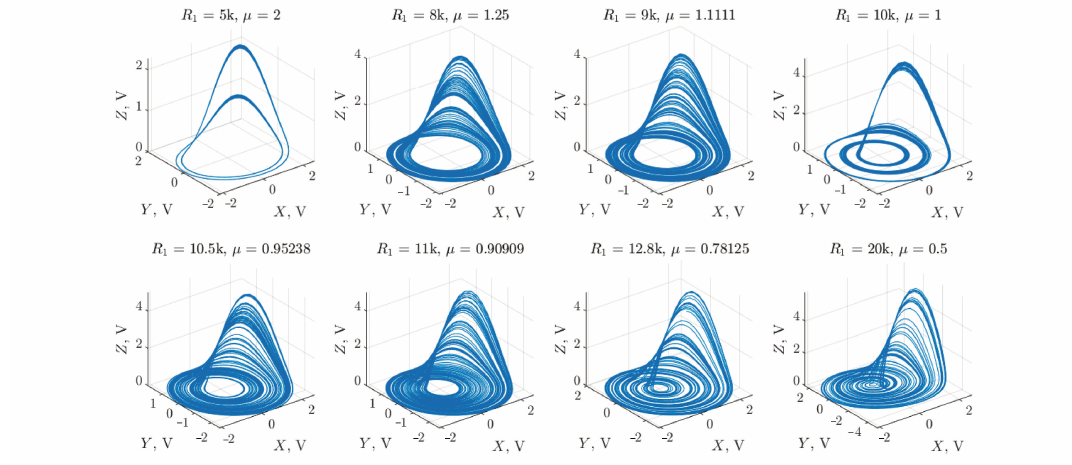
Figure 12. Attractors acquired from the Rössler modeling circuit with mathematical parameter values a = b = 0.2, c = 5.7 and the altered resistor R 1 . Here, µ = R 0 / R 1 . The case µ = 1 corresponds to a normal Rössler oscillator; other cases show the deliberate corruption of the